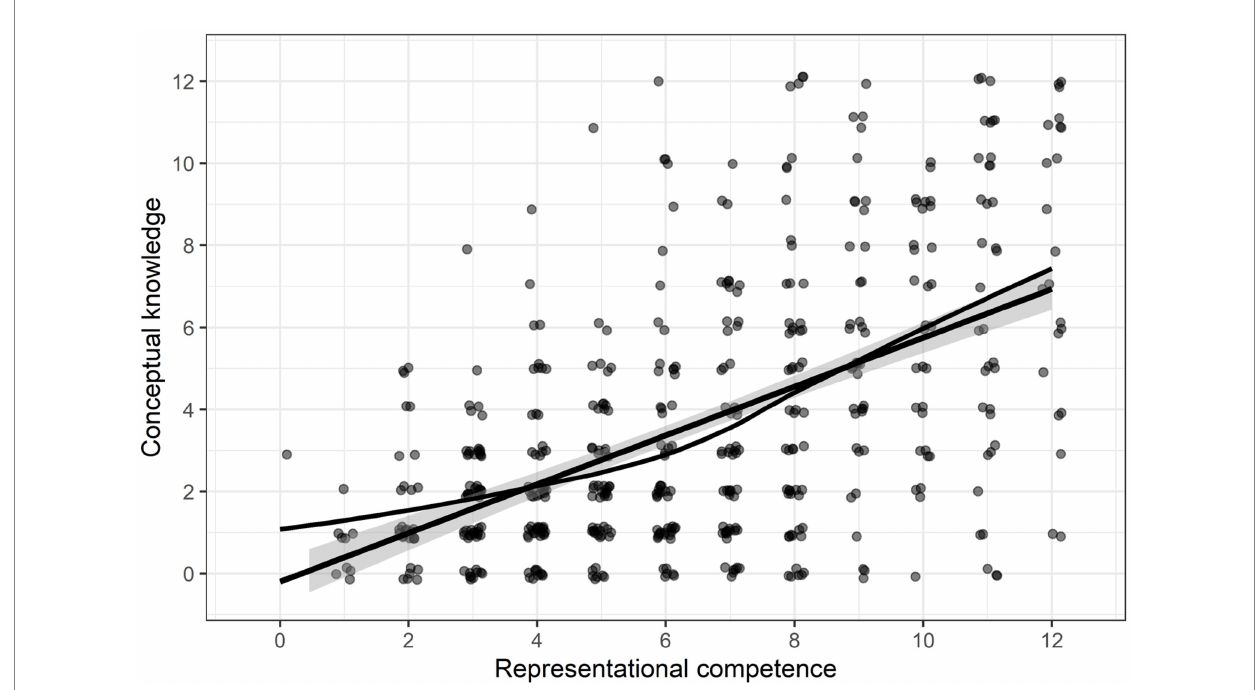
FIGURE 1 Scatter plot of representational competence and conceptual knowledge in data by Malone et al.